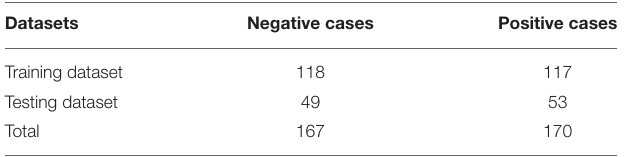
TABLE 3 | Data distribution of training and testing dataset.